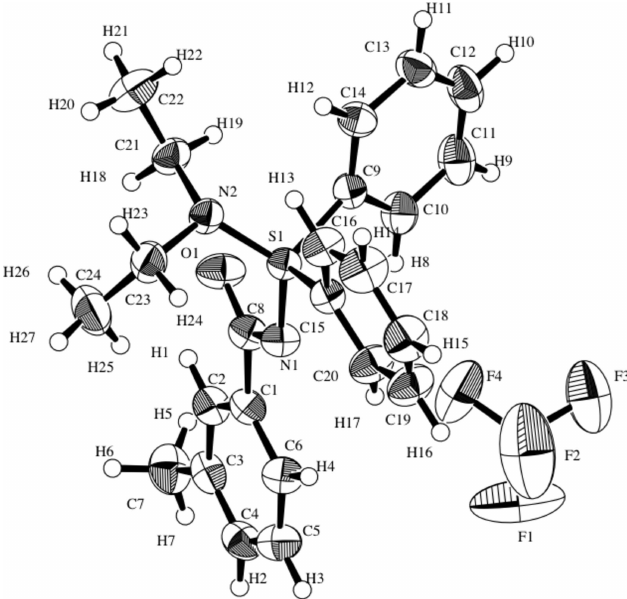
Figure 1 The molecular structure of the title compound, showing the atom labelling. Displacement ellipsoids are drawn at the 50% probability